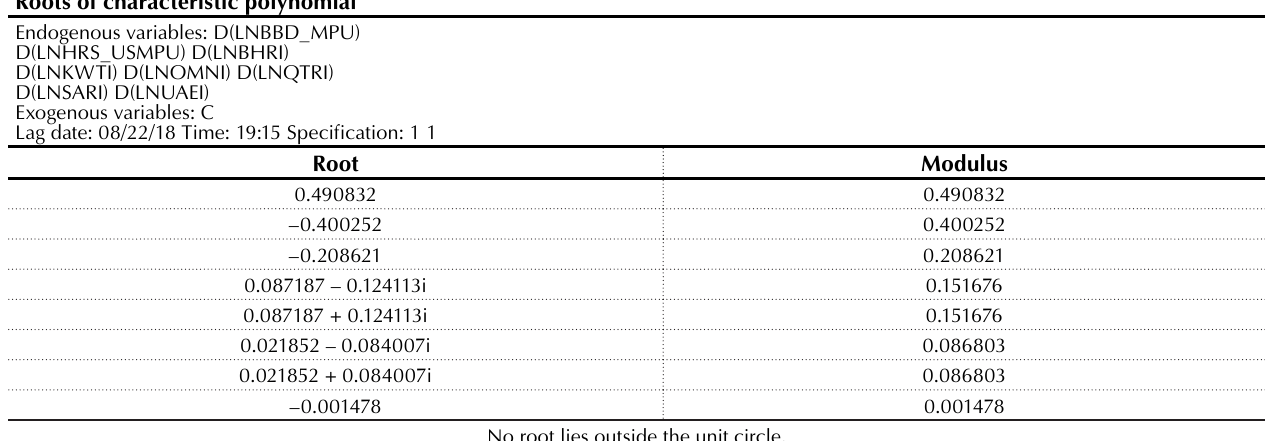
Table A3. The AR root test Roots of characteristic